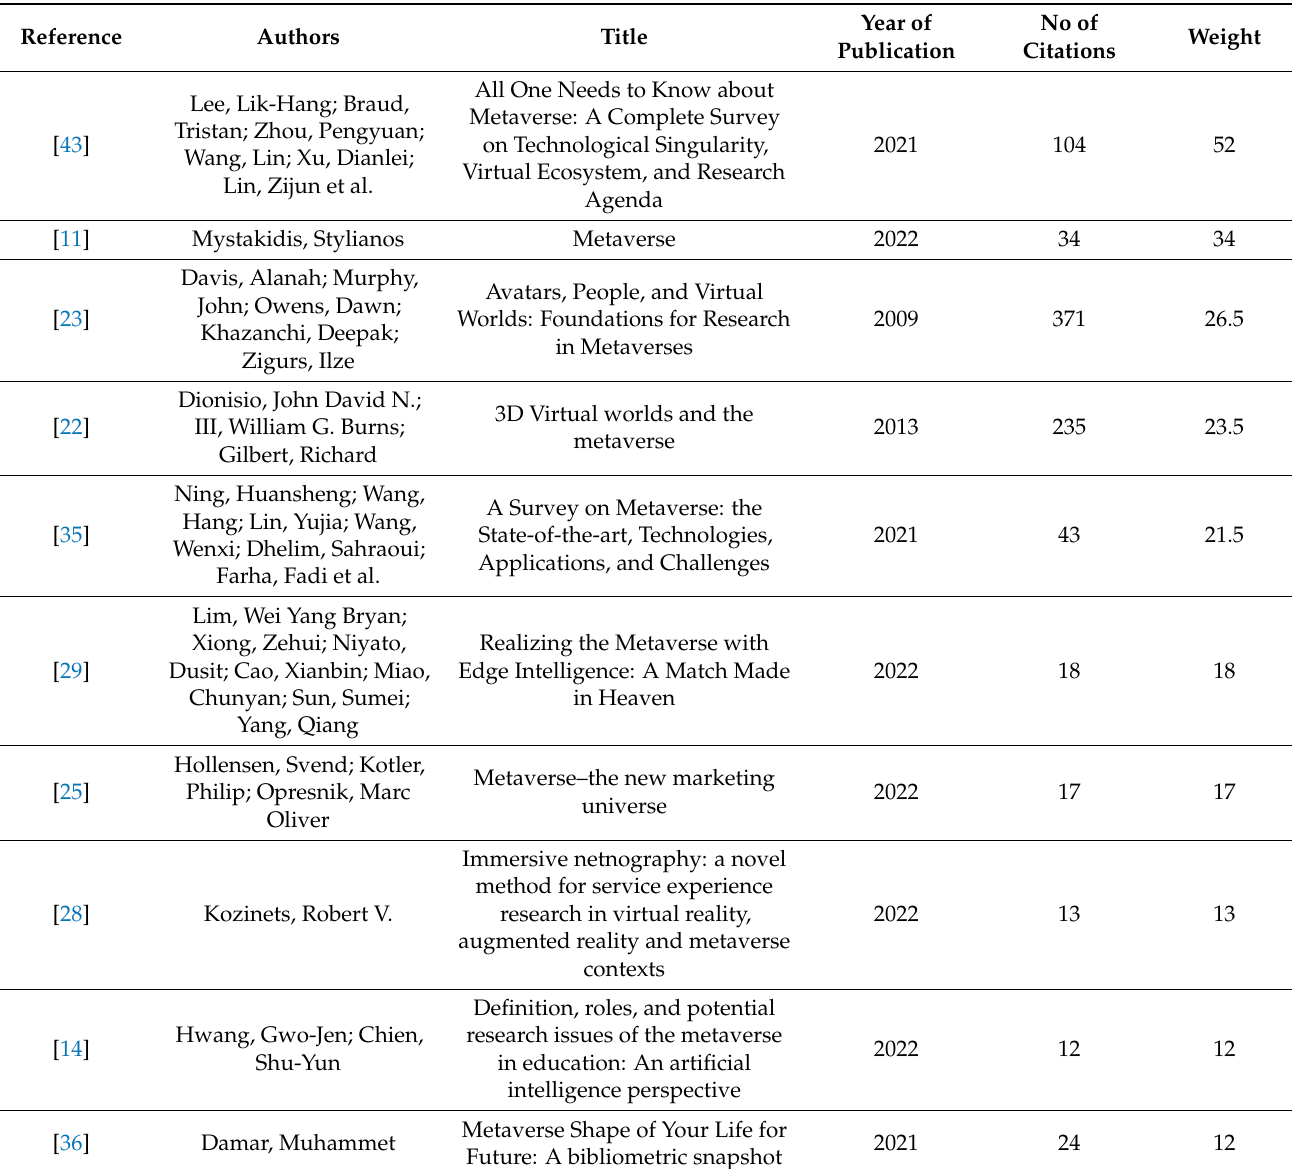
Table 2. Results after weighing the documents included for further